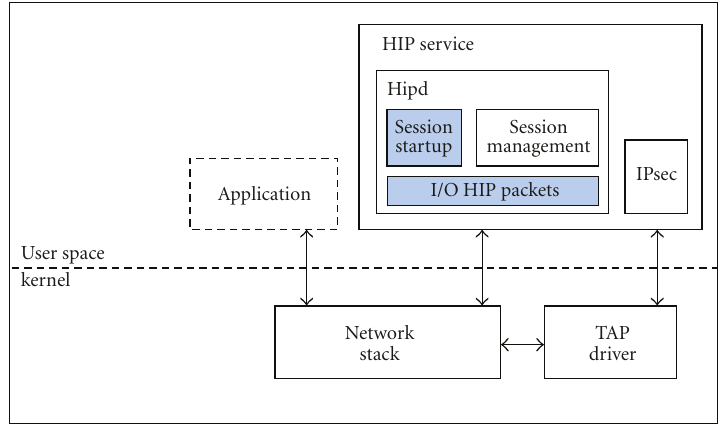
Figure 6: Integration of the HIP service with other Linux software